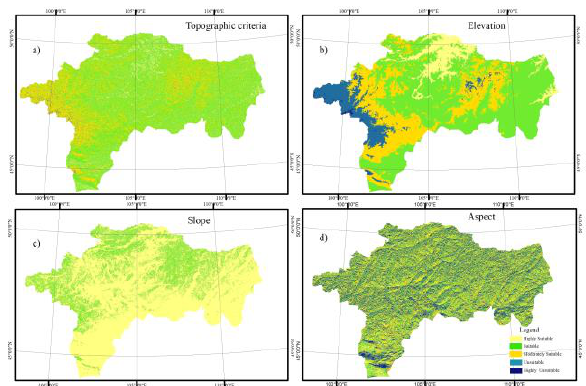
Figure 6. a) Topographic criteria with related factor as b) elevation, c) slope percentage, and d) aspect.